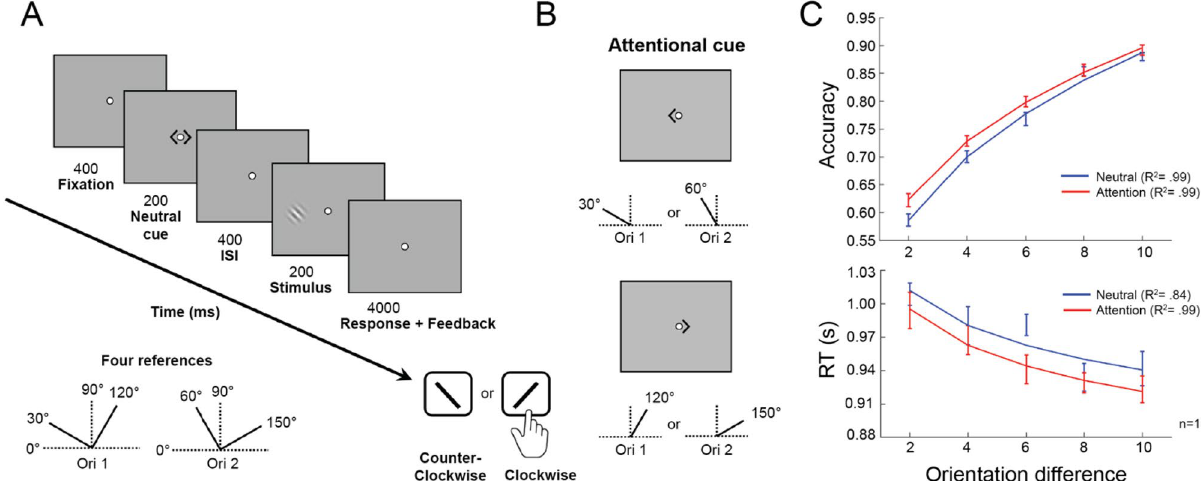
Figure 1. Perceptual benefit of feature-based attention in the orientation discrimination task. ( A ) Illustration of the orientation discrimination task. Before each block, one of the reference combinations (bottom left), each consisting of two reference orientations (30°/120°, or 60°/150°), was shown to observers, but never appeared on the screen during the stimulus presentation. In the task, each trial began with a fixation period of 400 ms followed by a 200 ms cue (neutral or attention). After 400 ms ISI, a Gabor stimulus was presented for a single interval of 200 ms, and the observer’s task was to judge whether the orientation of the stimulus was counter- clockwise or clockwise relative to the closest reference orientation shown before the block with a key-press within 4 s. ( B ) Attentional cue. In the attention condition, the cue was either a leftward arrowhead indicating a reference angle of 30° or 60°, or a rightward arrowhead indicating 120° or 150°, depending on which reference combination was used in each block. ( C ) Deploying FBA (red line) significantly improved accuracy (upper panel) in the orientation discrimination task, without any speed-accuracy trade-off (lower panel) compared to the neutral condition (blue line). Error bars represent ± 1 within-subject SEM.